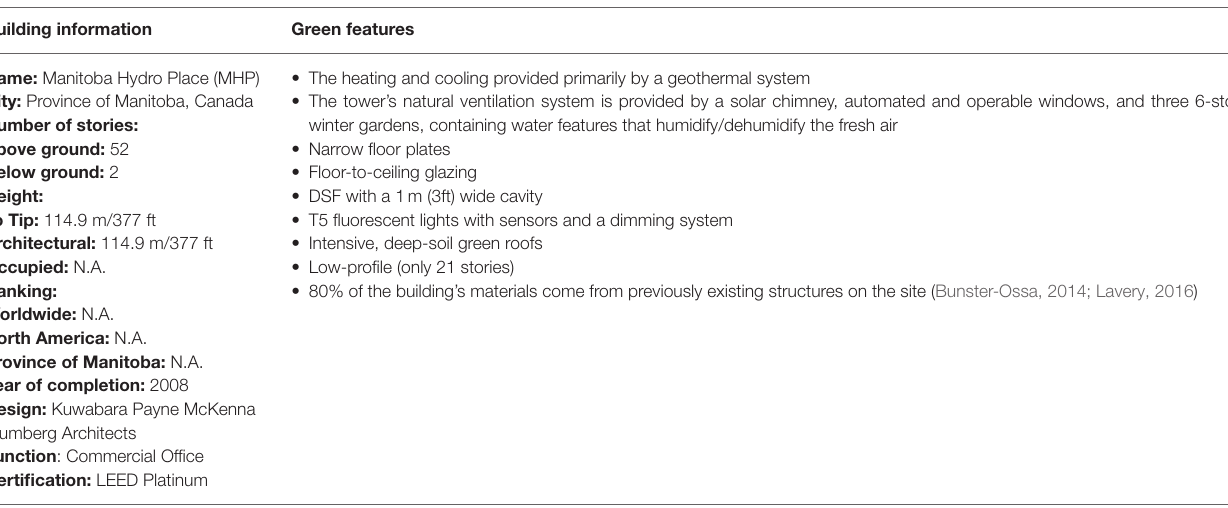
TABLE 7 | Manitoba Hydro Place (MHP): Key green features. Building information Green features